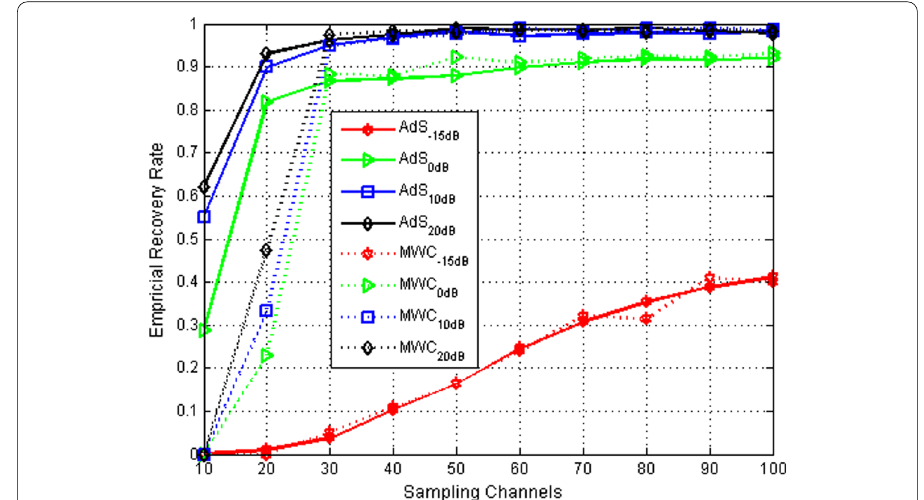
Fig. 10 Percentage of correct support recovery, when SNR